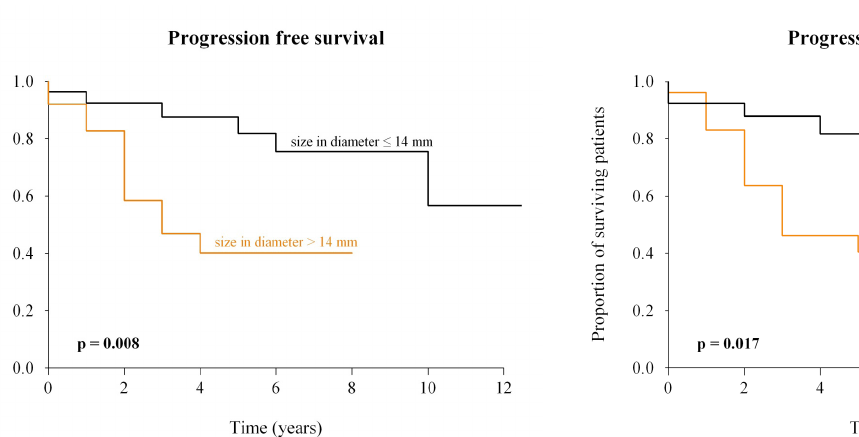
Fig. 2. Progression free survival (until presence of metastasis or death due to observed diagnosis of melanoma) by abnormalities of chromosome 3 (P value of log-rank test is presented).